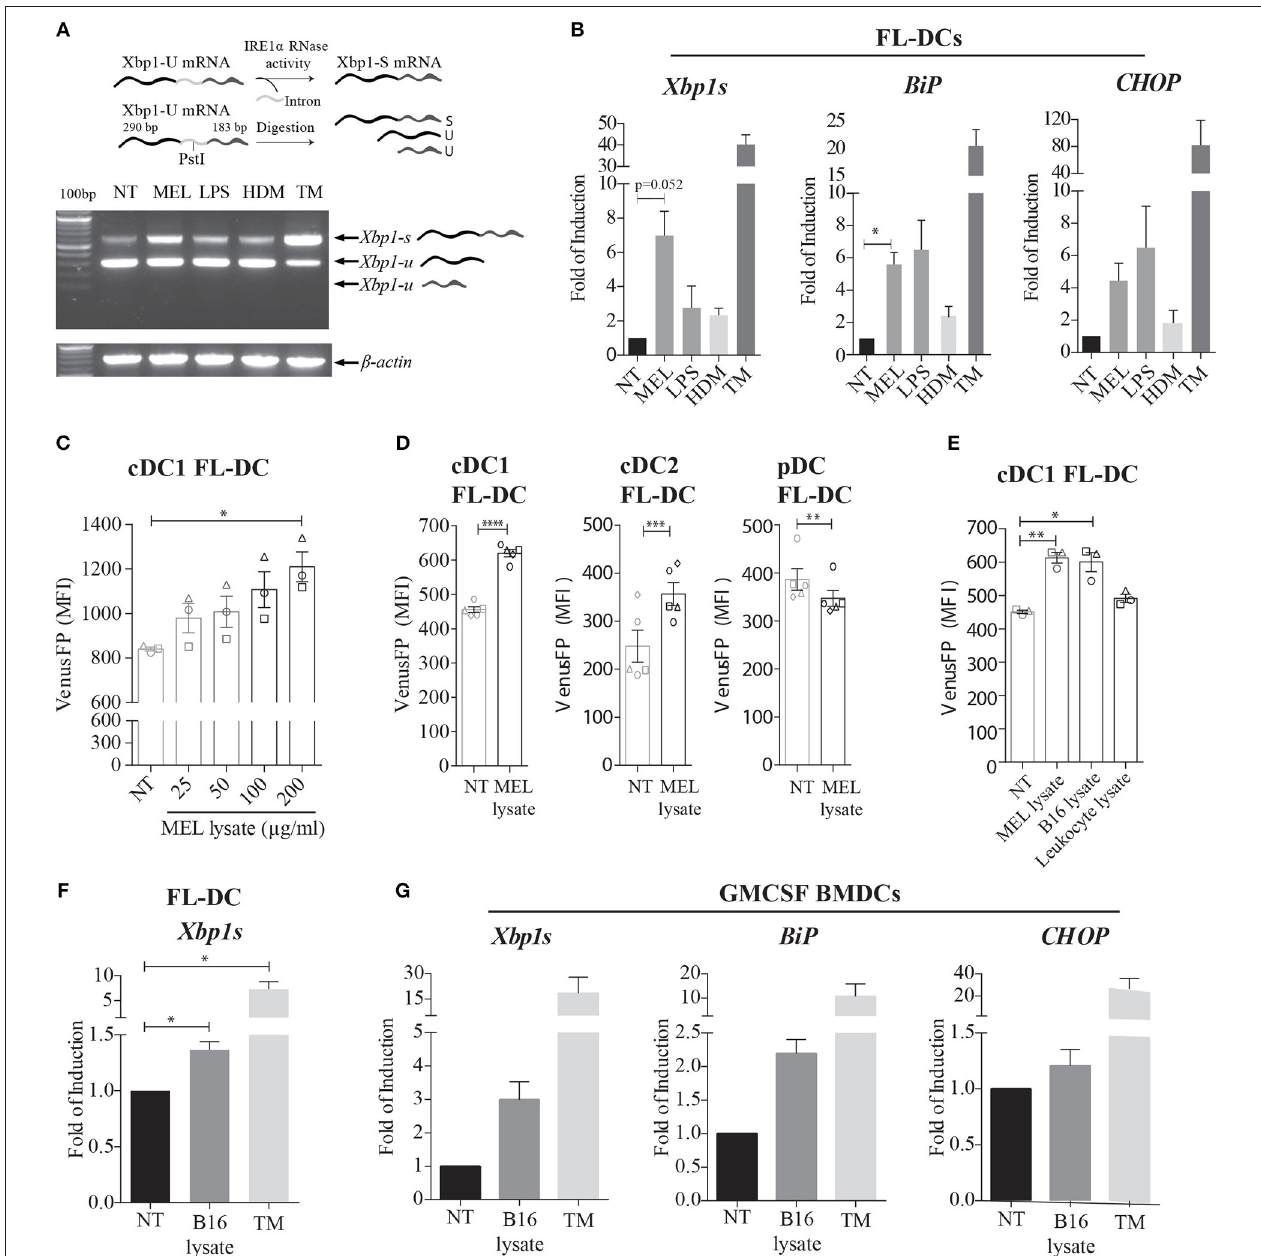
FIGURE 1 | Human and murine melanoma cell lysates induce expression of XBP1s and additional members of the UPR in murine BMDCs. (A) FL-DCs were left untreated (NT) or stimulated with 100 µ g/ml cell lysate from human melanoma cell lines (MEL), 100ng/ml lipopolysaccharide (LPS), 50 µ g/ml house dust mite extract (HDM), or 1 µ g/ml tunicamycin (TM) for 8h. Expression of Xbp1s was determined by a RT-PCR protocol for Xbp1s and Xbp1u that includes a digestion step with the restriction enzyme PstI. The Pst I digestion site in the intron of Xbp1u mRNA allows the distinction between Xbp1s and two fragments of Xbp1u mRNA. A representative scheme is illustrated. Data is representative of three independent experiments. (B) FL-DCs were stimulated as in (A) and expression of Xbp1s , BiP , and CHOP mRNA was measured by qPCR relative to L27 expression, and depicted as fold of induction to the NT condition. Data in graphs depicts three independent experiments. (C) FL-DCs generated from ERAI mice were left untreated (NT) or stimulated with 25, 50, 100, and 200 µ g/ml of MEL for 16h for the quantification of VenusFP expression. Data in graphs depicts the MFI of cDC1 FL-DC (XCR1 + ) of three independent experiments. (D) ERAI FL-DCs were NT or stimulated with 100 µ g/ml MEL for 24h for the quantification of VenusFP expression. Data in graphs depicts the MFI of cDC1 FL-DC (XCR1 + ), cDC2 FL-DC (SIPR α + ), and pDC FL-DC (B220 + ). (E) ERAI FL-DCs were NT or stimulated with 100 ug/ml MEL, 100 ug/ml human leukocyte cell lysate or 100 ug/ml B16F10 murine melanoma cell lysates (B16 lysate) for 24h to evaluate VenusFP expression. Data in graphs depicts the MFI of cDC1 FL-DC (XCR1 + ) of three independent experiments. (F) FL-DCs were left untreated (NT) or stimulated with 100 µ g/ml B16 lysate or 1 µ g/ml TM for 8h and expression of XBP-1s was measured by qPCR. Data in graphs